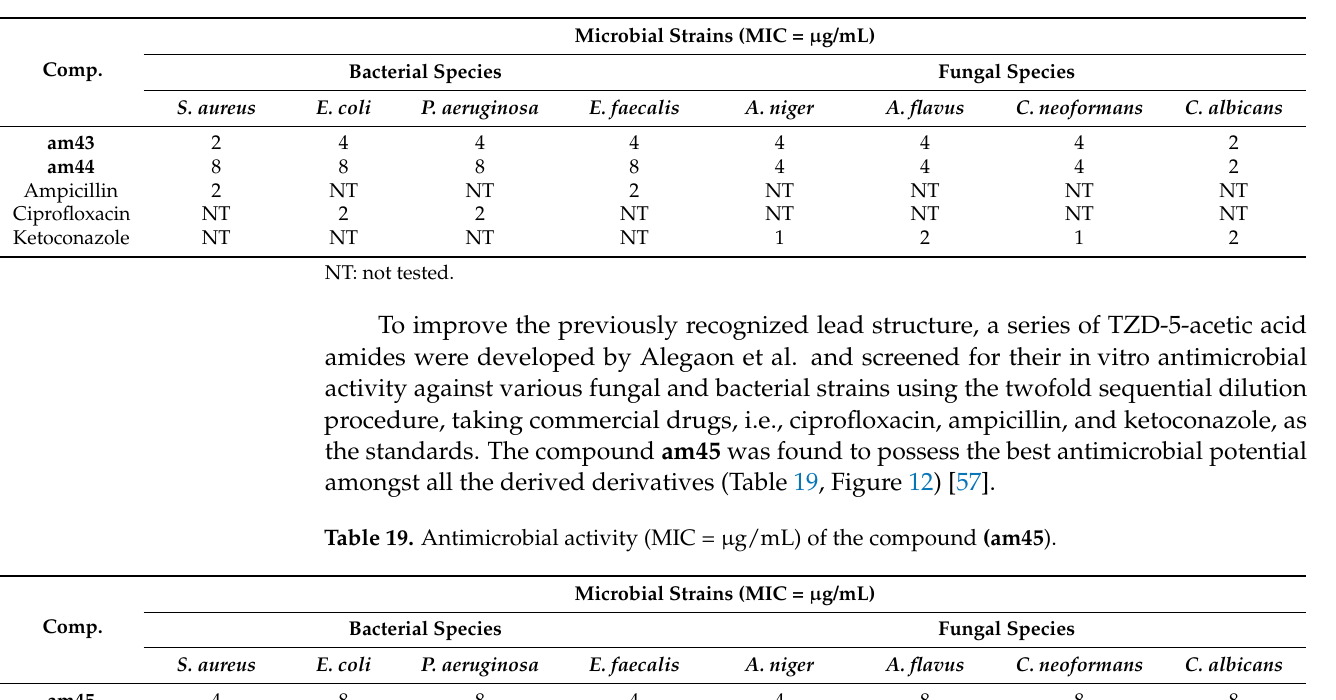
Table 18. Antimicrobial activity (MIC = µ g/mL) of the compounds (am43 – am44 ).